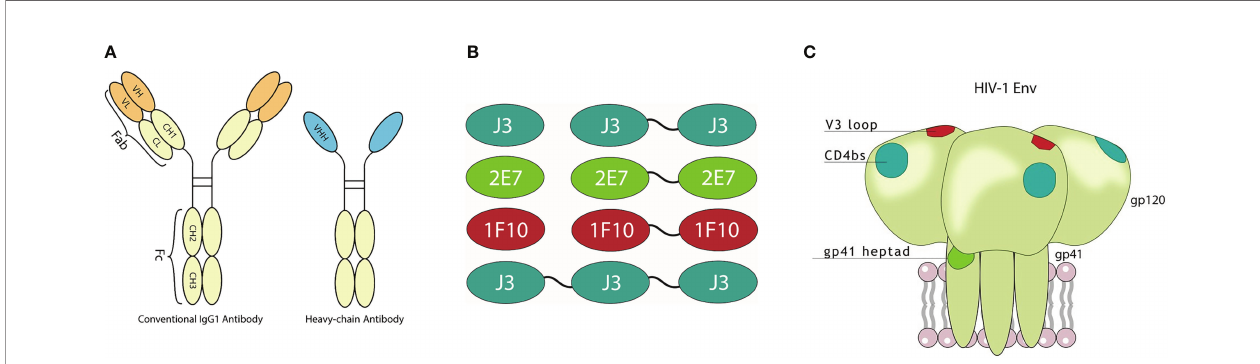
FIGURE 1 | Visualization of nanobodies and their target epitope. (A) Schematic representation of a conventional immunoglobulin (IgG) antibody and a camelid heavy-chain only antibody with visualization of their variable domains. (B) Monovalent, bivalent and trivalent J3 targeting the CD4bs, monovalent and bivalent 1F10 targeting the V3 loop and monovalent and bivalent 2E7 targeting the gp41 heptad repeat-1 (HR1). (C) Schematic diagram of the HIV-1 trimeric envelope glycoprotein complex showing the epitopes that are recognized by the broadly